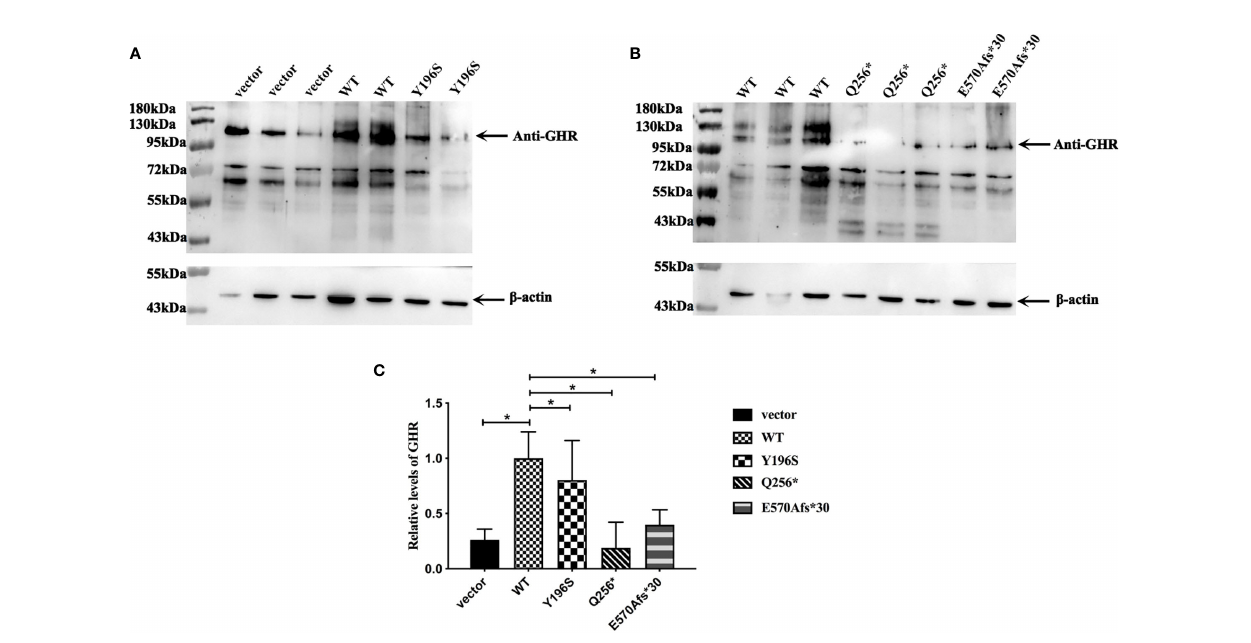
FIGURE 4 | (A, B) Expression of GHR protein in HepG2 cells transfected with pcDNA3.1(+) empty vector, GHR wild type (WT) and mutant expression plasmids (Y196S, Q256* and E570Afs*30). The GHR protein has a molecular weight of around 130 kDa. Protein bands corresponding to 130 kDa could be detected in HepG2 cells transfected with Q256* and E570Afs*30, and the relative expression of both of them were signi fi cantly decreased compared to GHR-WT ( C , P<0.05). HepG2 cells transfected with Q256* mutant plasmid produced a truncated protein, with a molecular with of around 43kD. However, no truncated protein was